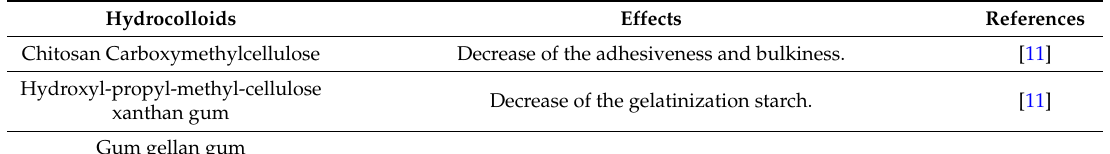
Table 1. Main ingredients and technological options used in the